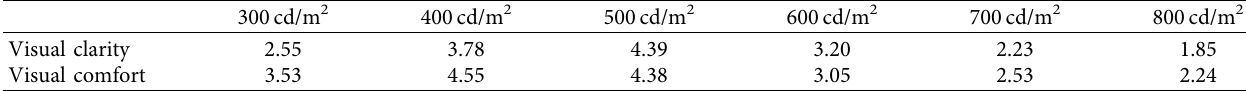
Table 1: Statistics of average scores of visual acuity and visual comfort in large batches of subjective